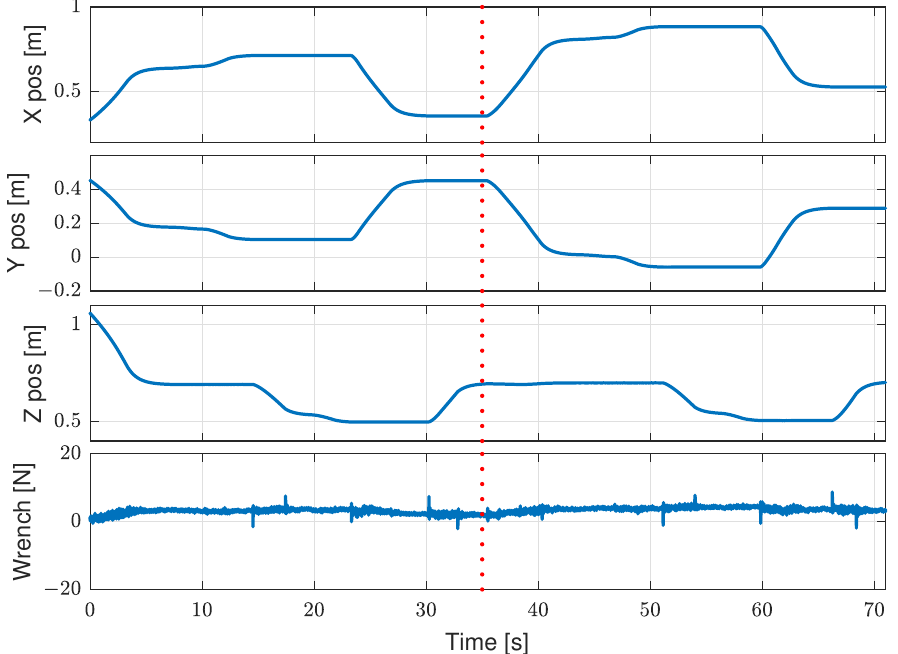
Figure 8. A depalletizing task where two boxes are successfully extracted. The mobile base is exploited to approach the boxes for the unloading task and to transport the boxes away once loaded on the